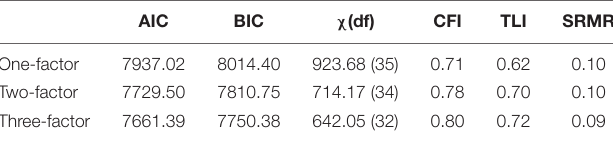
TABLE 2 | Indexes of model fit for three